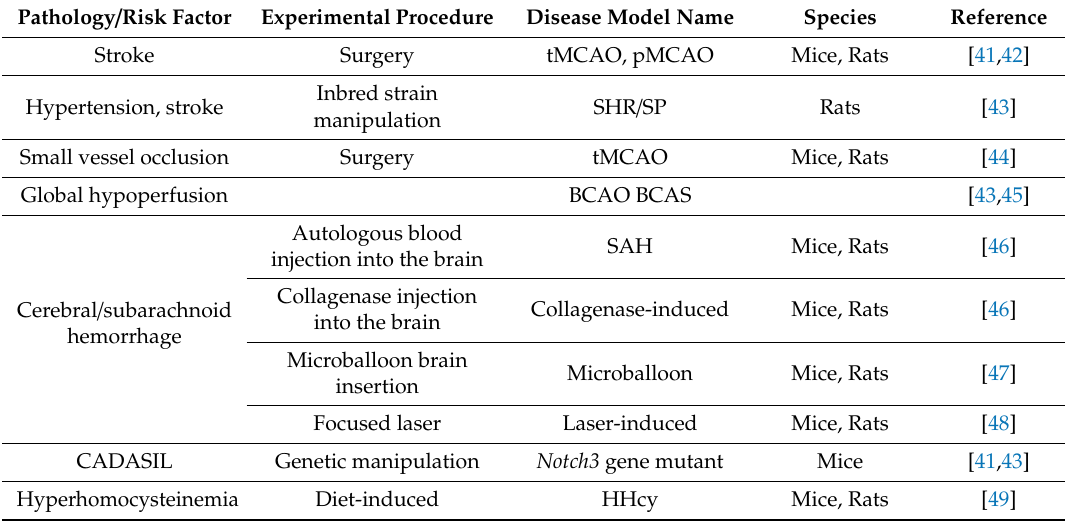
Table 1. Main rodent models to study vascular cognitive